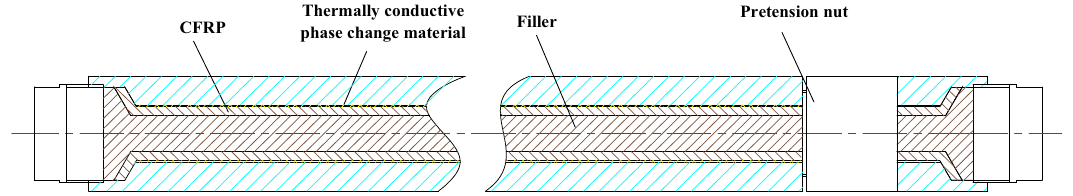
Figure 2: Structure of ball screw based on inner - embedded